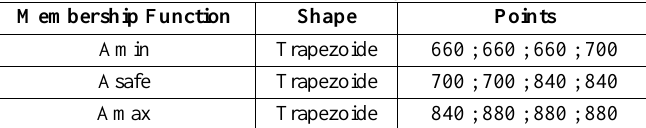
Table 5: Member functions of potentiometer A.